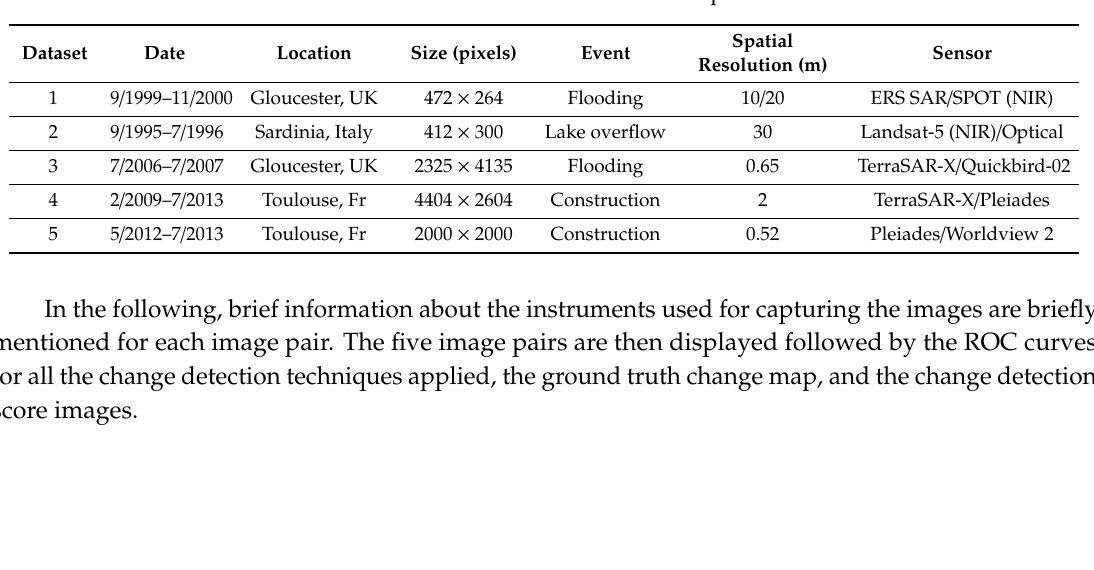
Table 1. Details of the five datasets in our